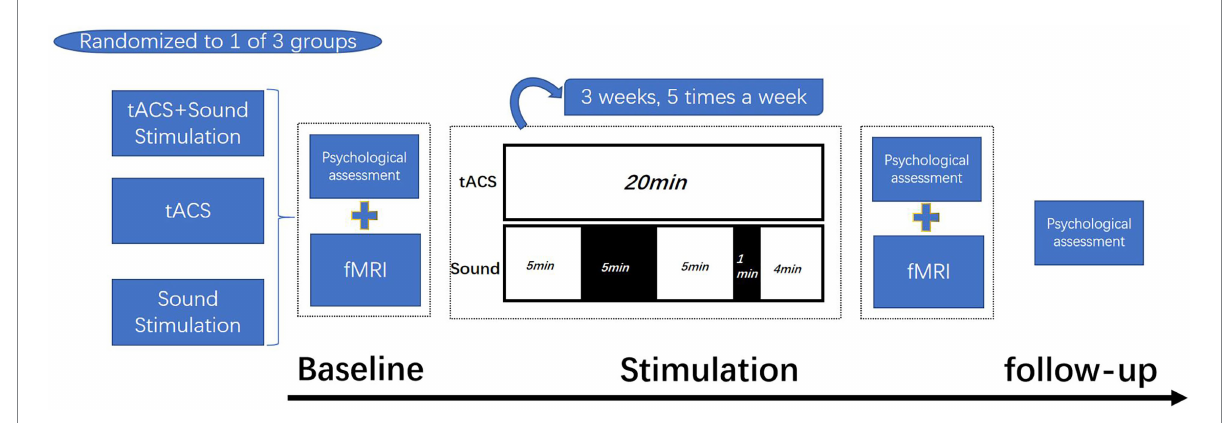
FIGURE 1 Test process. Patients are randomized into three groups who will receive a three-week (15 sessions) treatment of tACS combined with sound stimulation, tACS, and sound stimulation. tACS: 20 min/day; Sound stimulation: 14 min/day(stimulate for 5 min, rest for 5 min, stimulate for 5 min, rest for 1 min, and stimulate for 4 min). Psychological assessments were made at baseline, after treatment, and at follow-up, and fMRI was applied at baseline and after